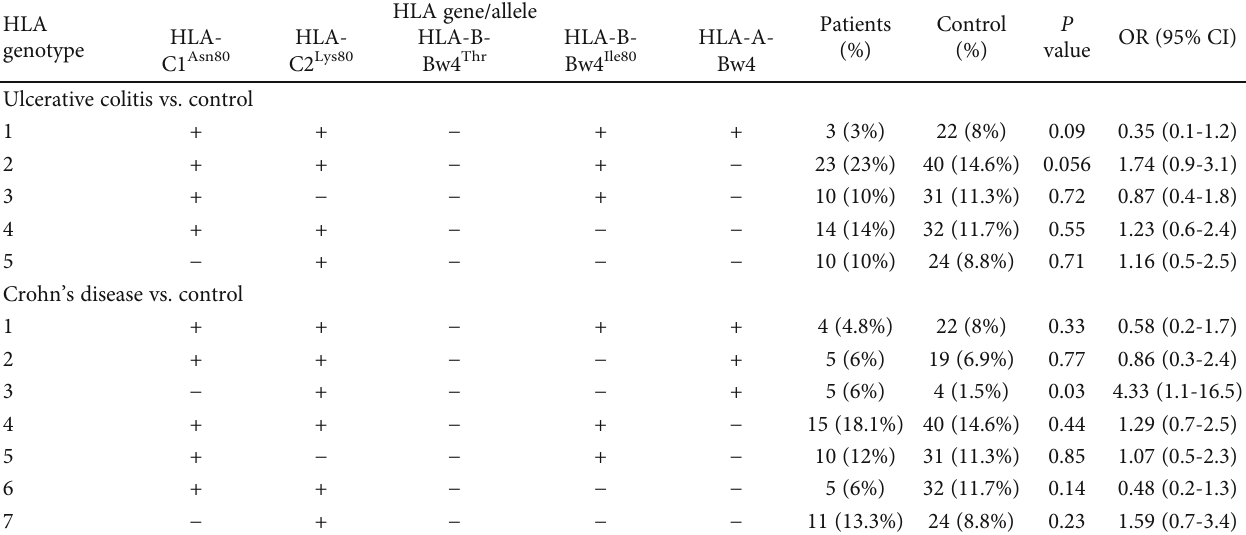
Table 3: Human leukocyte antigen (HLA) genotypes in normal individuals and IBD patients.